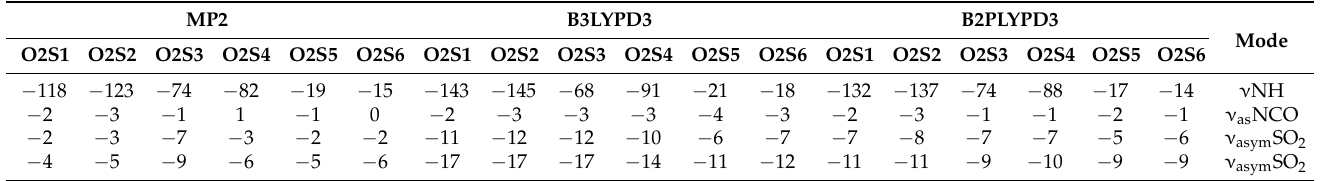
Table 5. Selected wavenumber shifts calculated for the 1:2 complexes using the MP2, B3LYPD3 and B2PLYPD3 methods with basis set